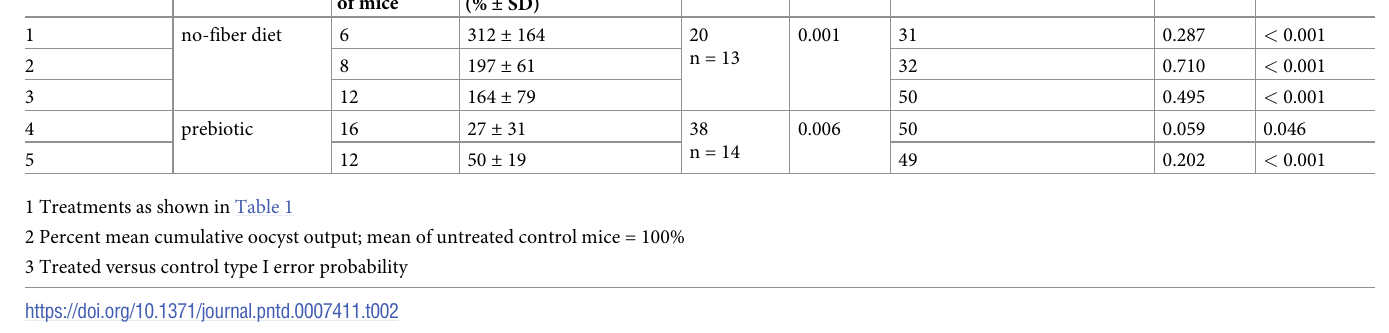
control mice. The effect of dietary treatment tested over the 3 experiments was statistically sig- alternative analysis based on individual fecal samples also revealed a significant effect of diet for all three experiments (U = 56, n = 15, p = 0.02; U = 118, n = 24, p = 0.001; U = 392, n = 36, p = 0.004). Fig 1 shows overnight oocyst output over time for the three experiments. We per- formed analogous experiments to test the effect of prebiotics, which are in essence fermentable fibers (S1 Table). The impact of the dietary supplement on the severity of Cryptosporidium infection was also significant (U = 38, n = 14, p = 0.006; Table 2). This effect was apparent when prebiotics were given to mice fed no-fiber diet (experiment 5, U = 542, n = 47, p = 0.001) or regular diet (experiment 6, U = 305, n = 30, p = 0.033). Fig 2 shows the pattern of oocyst production over time for prebiotic experiments 4 and 5. Body weights were recorded multiple times during each experiment. In none of the experiments was a statistically significant effect of the treatment on the final weight identified.